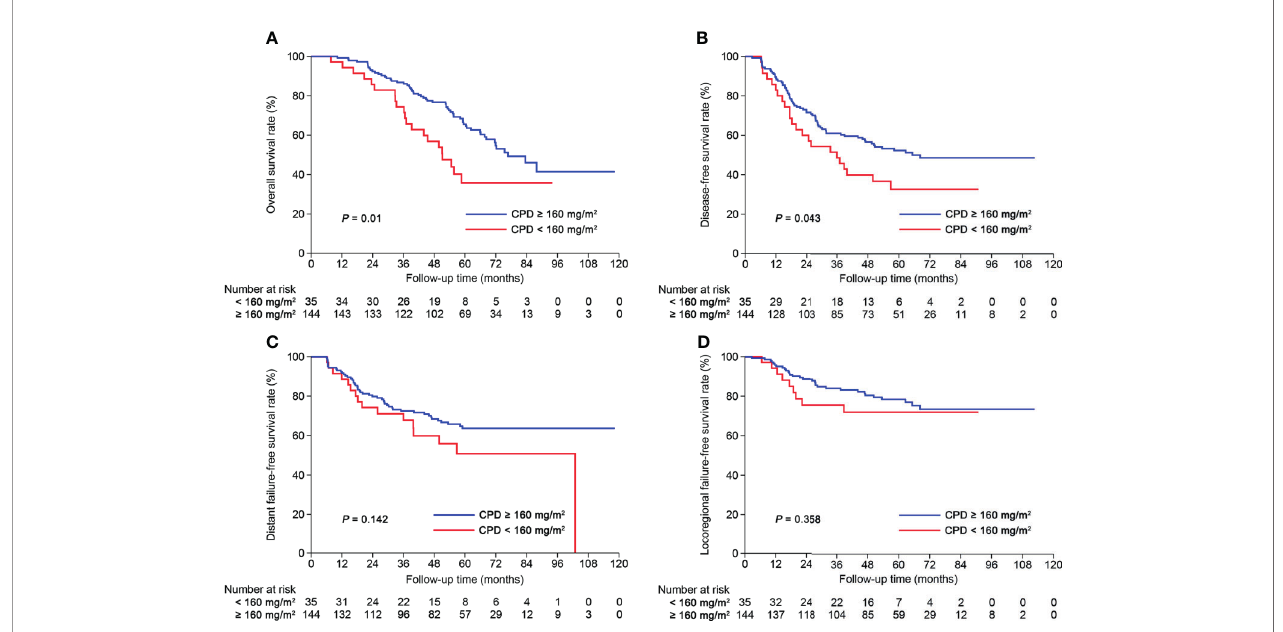
FIGURE 6 | Kaplan-Meier curves of (A) overall survival, (B) disease-free survival, (C) distant failure-free survival and (D) locoregional failure-free survival for patients with stage III-IV RPA1 receiving cumulative platinum dose < or ≥ 160 mg/m 2